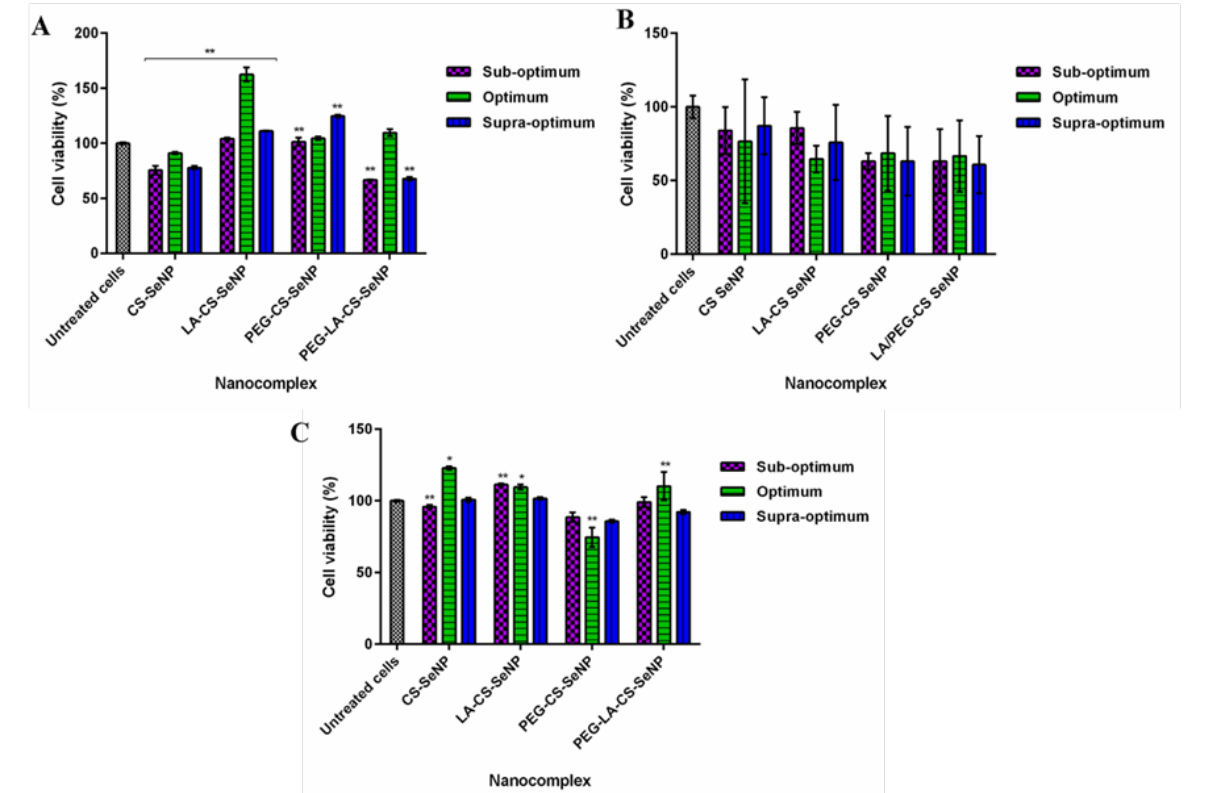
Figure 8. Cytotoxicity profiles of FSeNP nanocomplexes after 48 h in ( A ) HEK293, ( B ) Caco-2, and ( C ) HepG2 cell lines. Column data are represented as the mean ± SD ( n = 3). Untreated cells were used as the control and taken as 100% viability. * p < 0.05 and ** p < 0.01 show a statistical significance between similar ratios of targeted vs untargeted nanocomplexes using two-way ANOVA.